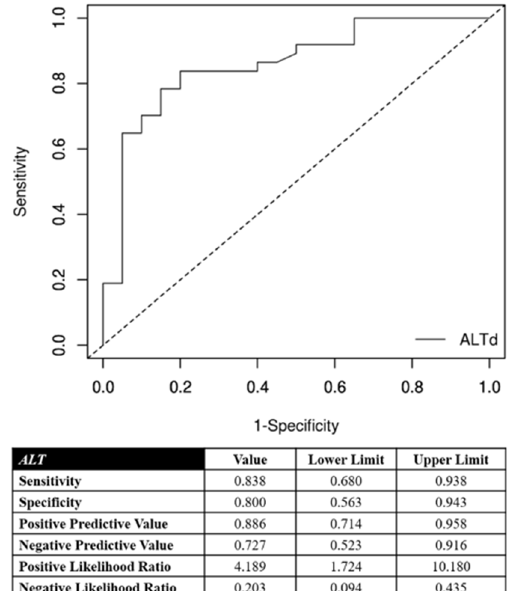
Figure 3. Correlation between alanine aminotransferase (ALT) increase and the objective response for target nodules. In the lower portion of the figure, the performance measures are reported using the optimal cutoff point (52%).